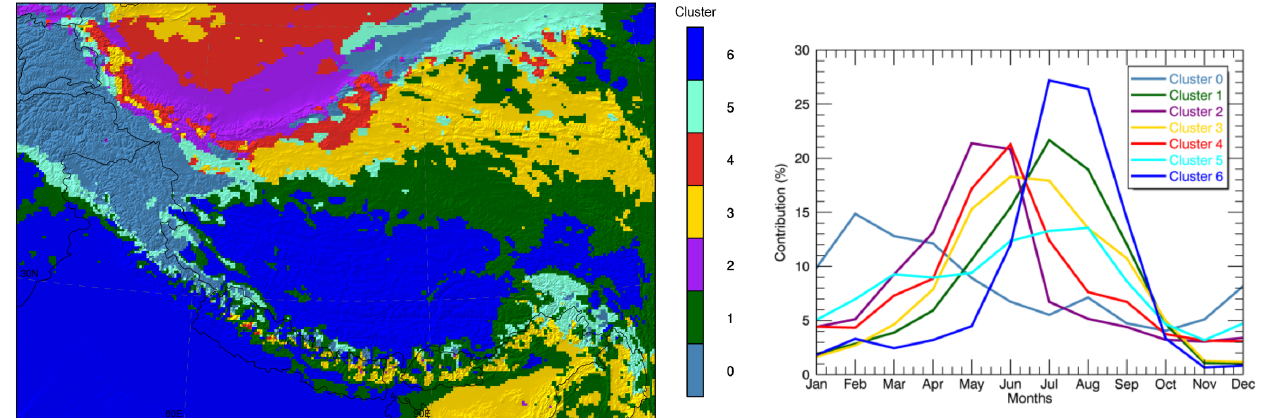
Figure 2. Precipitation clusters (left) and the mean annual cycle of percentage contribution of monthly precipitation to annual precipitation for each cluster